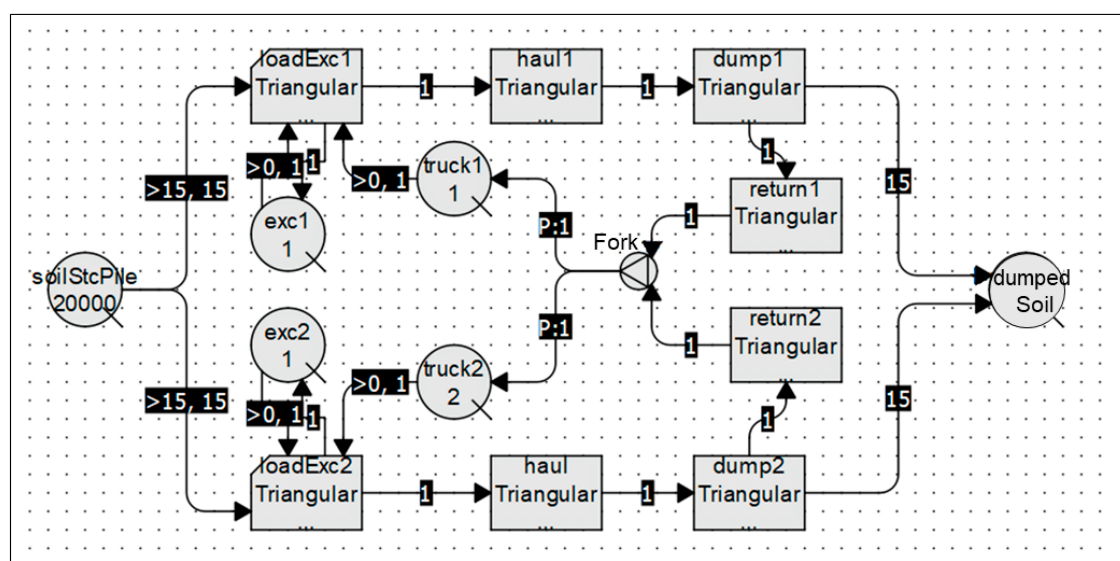
Figure 13. DES model of the earthmoving operations.